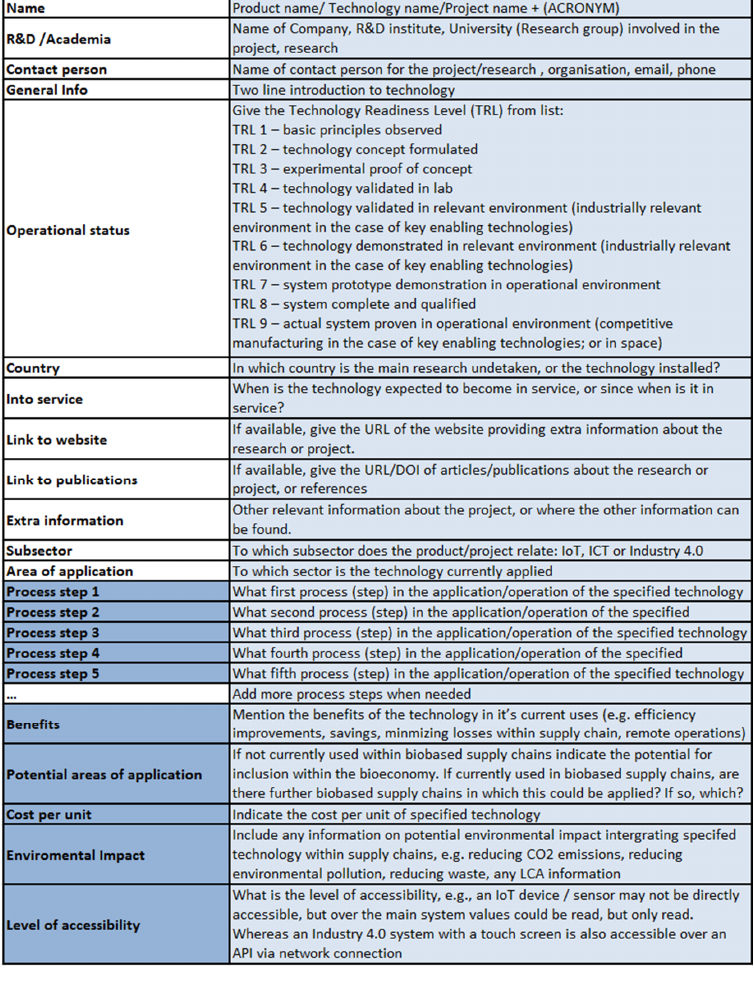
Figure A1. Template used to collect information about the ICT, IoT, and Industry 4.0 technologies, tools, and solutions for biomass supply chains.